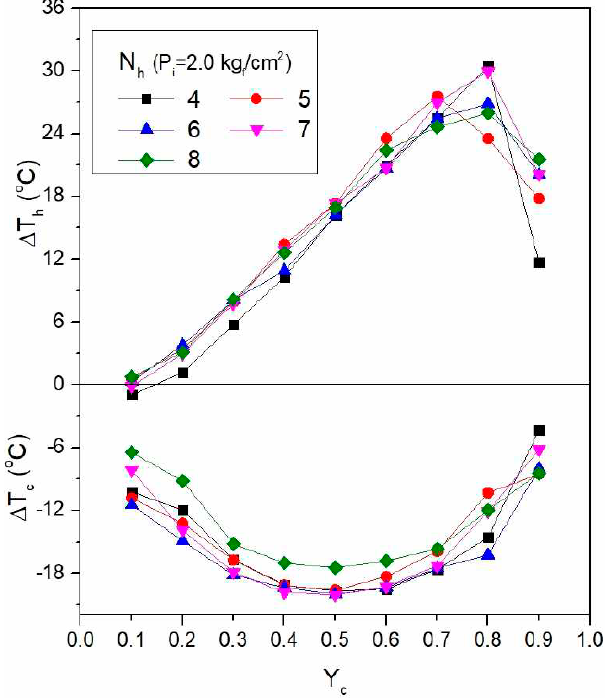
Figure 14. Temperature differences ∆ T h and ∆ T c according to inlet pressure (P i ) 2.0 kgf/cm 2 .